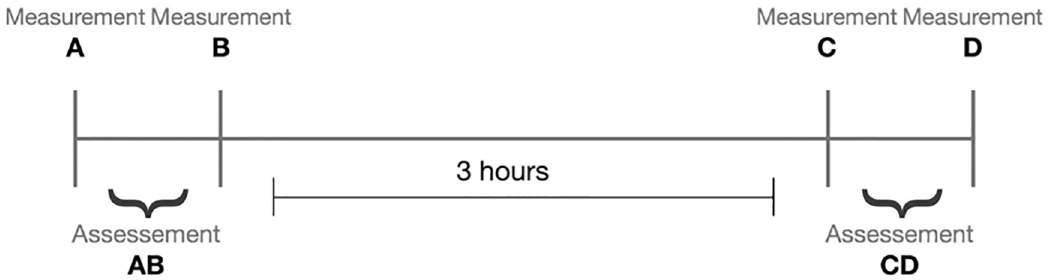
Fig 1. Schematic representation of the measurements performed by each observer in each participant.